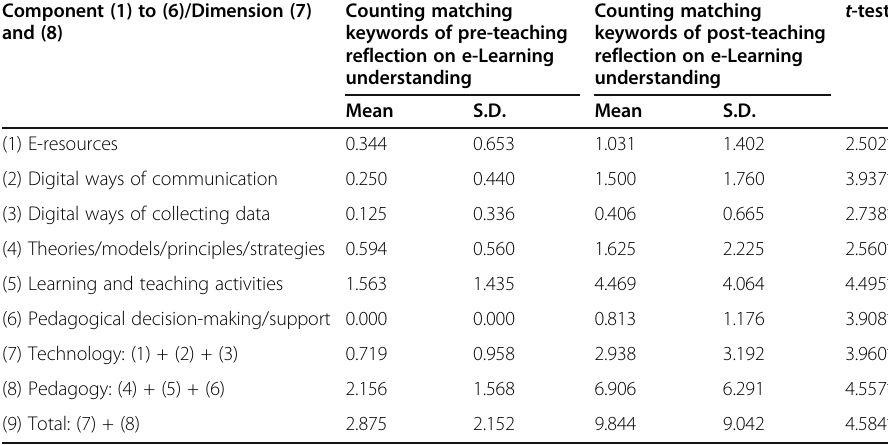
Table 5 Comparison of means of counting matching keywords from the results on computer- aided analysis of learners ’ pre-teaching and post-teaching reflections on their understanding of e- Learning Component (1) to (6)/Dimension (7) and (8)